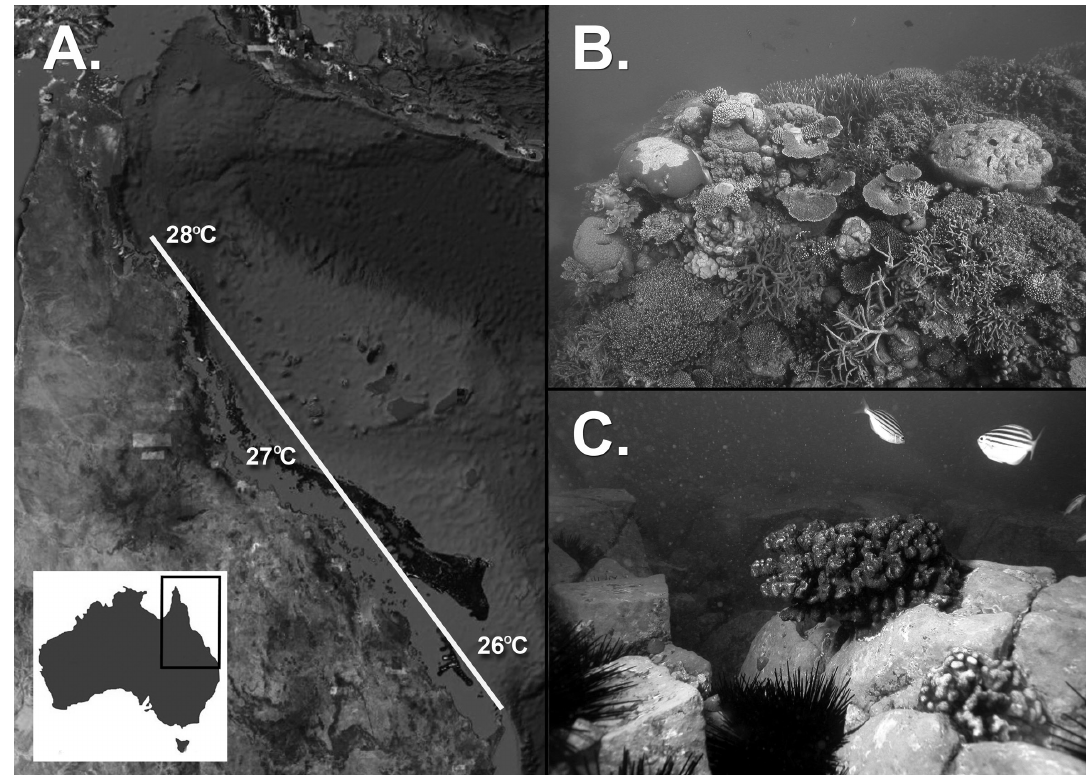
Fig . 1. – How fast would coral reef ecosystems have to travel if they were to keep up with the rapid shifts in sea temperature expected from climate change? A. Sea temperatures average 28°C in the northern Great Barrier Reef but decrease to an average of 26°C at the southern end (Done et al . 2003). Given that reef-building corals are locally adapted to temperature, the distance that would have to be travelled to keep pace with the 2°C increase in sea temperature by year 2100 would be 1500 km (white line). For a 2°C increase in temperature from climate change over 100 years, this would mean that coral reef ecosystems would have to travel 15 km per year (1500 km/100 years). B. The translocation of complex ecosystems such as the coral reef shown (Agincourt Reef, off Port Douglas, northern Australia) has not been seen over such short timeframes. C. Individual coral species (here, Pocillopora damicornis growing at the high-latitude site of Fingal Bay in temperate New South Wales) are already migrating to higher latitudes but the chance of forming complex carbonate coral reefs in a few decades appears to be near to zero. Photos: O.